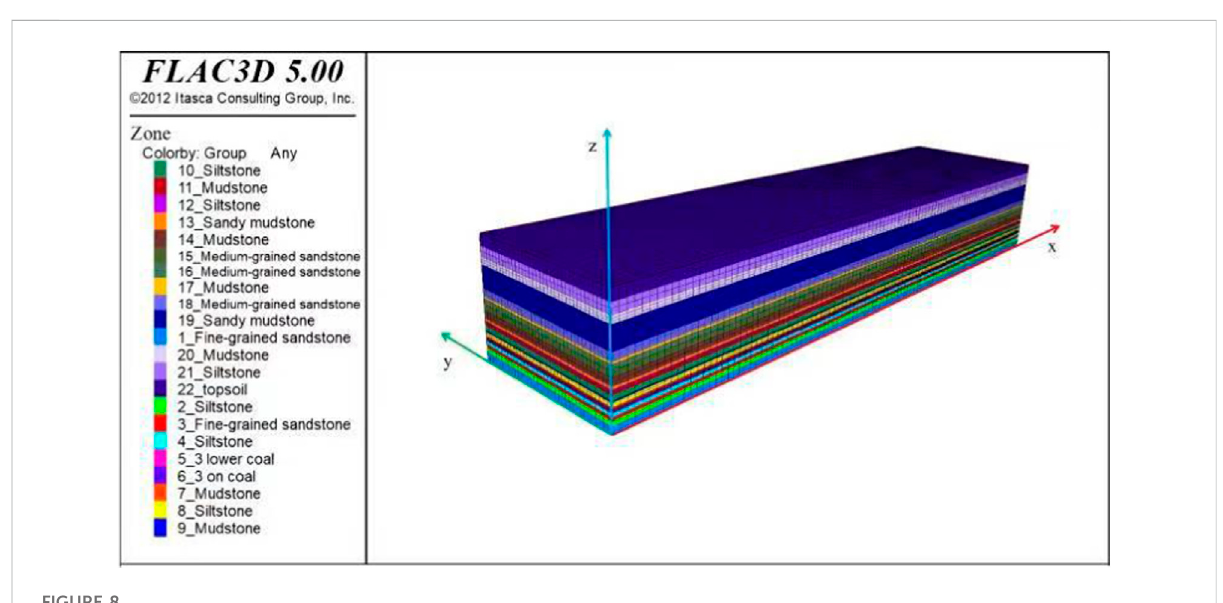
FIGURE 8 Numerical calculation